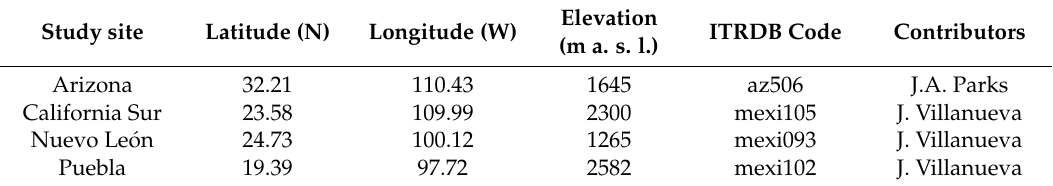
Figure 1. Map of the geographic distribution of Pinus cembroides and the location of the four study areas forming the species’ distribution limits ( a ). The graphs show the distribution of monthly precipitation (P) and mean temperature (T) in these four sites: Arizona ( b ), California Sur ( c ), Nuevo León ( d ), and Puebla ( e ). Table 1. Characteristics of the study sites. The International Tree-Ring Data Bank (ITRDB) code corresponds to the site where the tree-ring width chronology was developed.